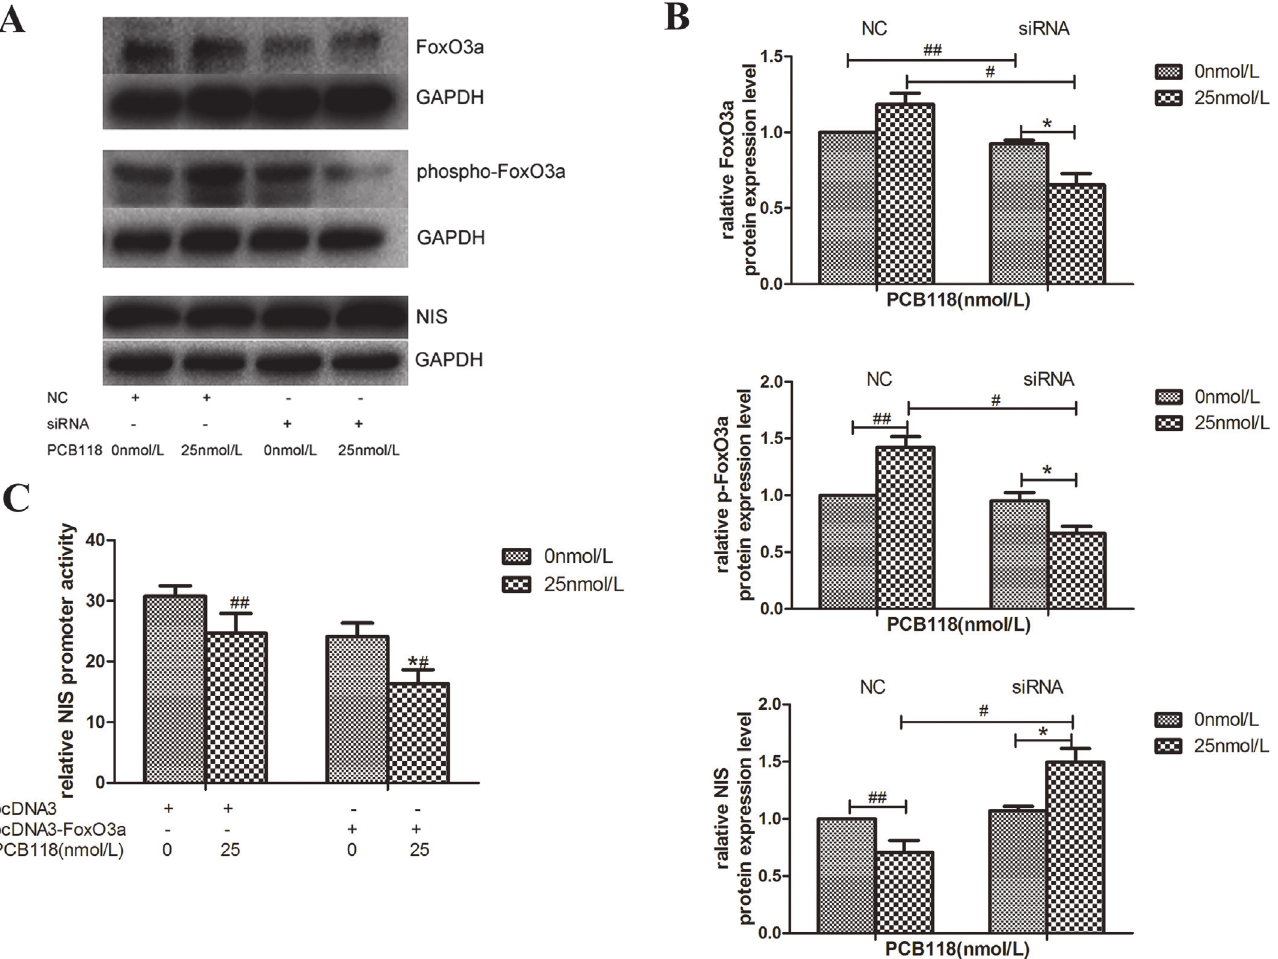
Fig 5. FoxO3a plays a role in the down-regulation of NIS expression in PCB118-treated FRTL-5 cells. FoxO3a was knocked down by FoxO3a-siRNA in FRTL-5 cells, and the cells were treated with PCB118 at 25 nM. Whole cell lysates were analyzed by western blotting using antibodies recognizing FoxO3a, p-FoxO3a, and NIS (A and B). FoxO3a over-expression was induced by the pcDNA3-FoxO3a plasmid, and the cells were harvested for the measurement of NIS promoter activity (C). Results show sections of blots from one experiment of the three that yielded similar results (A) or represent the mean ± SD of three independent experiments (B and C). GAPDH served as the loading control in western blotting. * p < 0.05, compared with the DMSO control group transfected with siRNA or the pcDNA3-FoxO3a plasmid; # p < 0.05, compared with the 25 nM PCB118-treated group transfected with the NC or pcDNA3 plasmid; ## p < 0.05, compared with the DMSO control group transfected with the NC or pcDNA3 plasmid. The relative ratio of target protein/GAPDH and promoter activity in solvent control group was set as